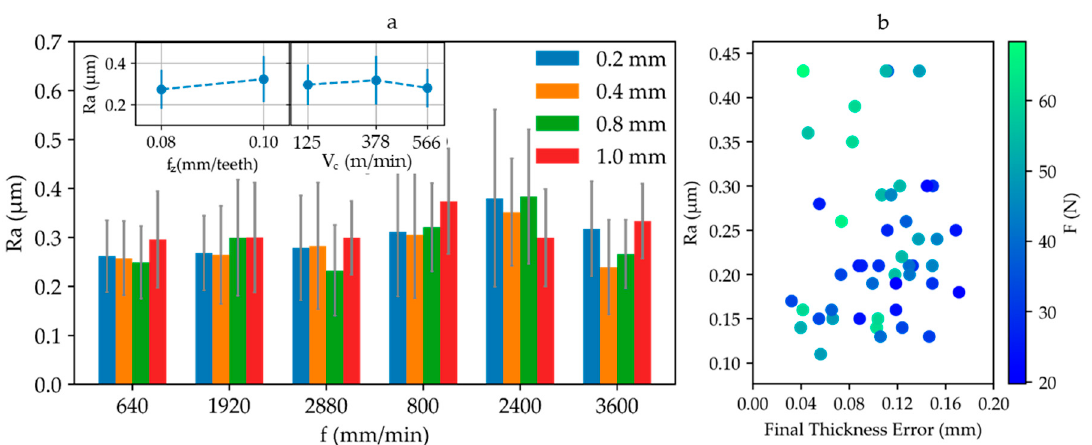
Figure 5. ( a ) Average of the roughness values obtained for di ff erent feed rates ( f = N · f z · S ) as a function of the depth of cut. The inlet shows the partial e ff ect of the feed rate per teeth and the cutting speed. ( b ) Average roughness values of each performed test against the depth of cut error considering the force module.